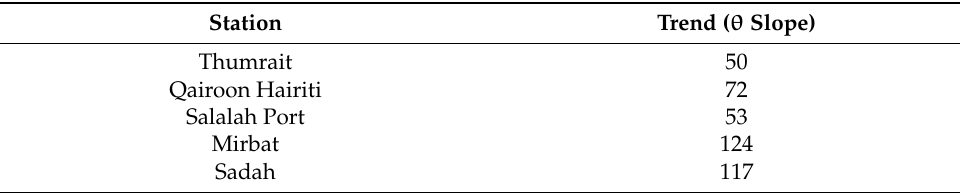
Table 4. Annual trend of rainfall accumulation from 2015–2020 obtained from the ERA5 model. Station Trend ( θ Slope) Thumrait 50 Qairoon Hairiti 72 Salalah Port 53 Mirbat 124 Sadah